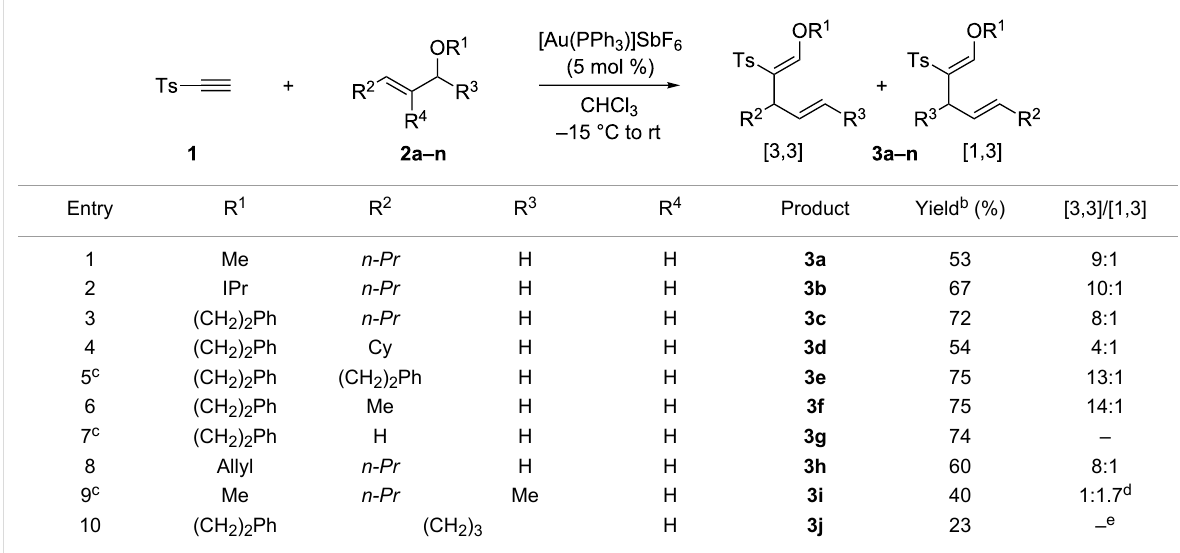
Table 2: Scope of the carboalkoxylation of sulfonyl acetylene ( 1 ). a